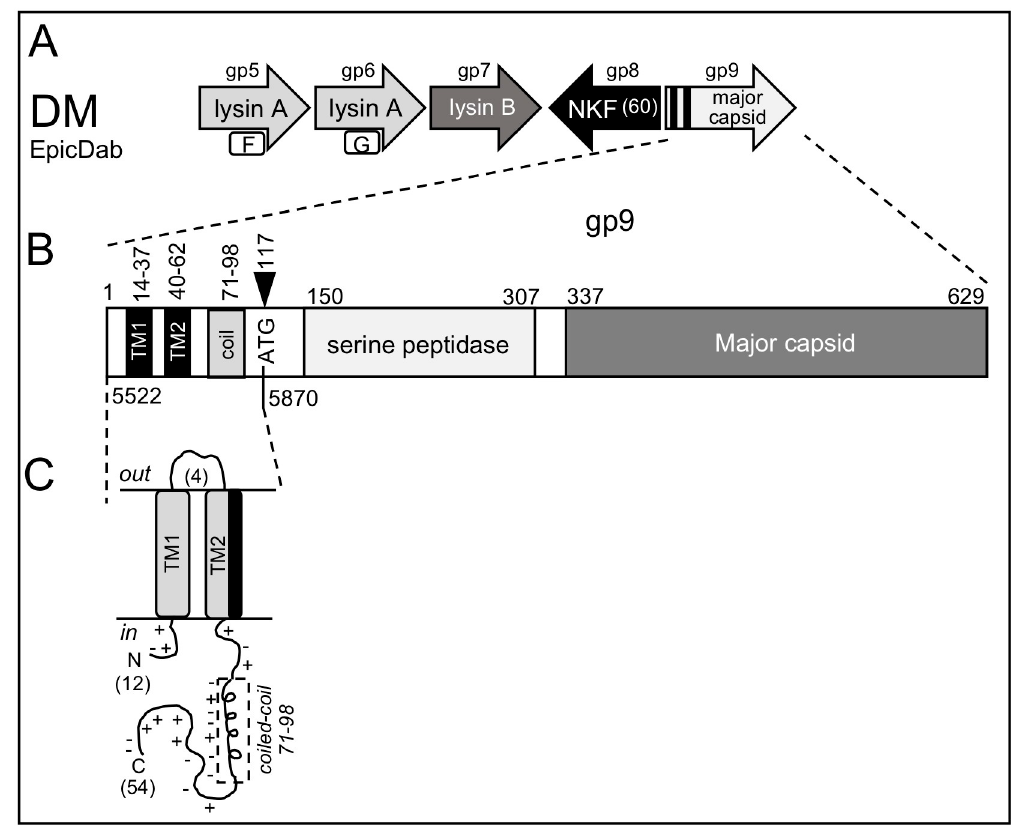
Fig 11. Genomic organization a lysis cassettes with a lysA and lysB in the same location and no holin like genes. A. The genomic structure is shown and the key to the schematic is presented in Fig 1. The direction of transcription of each gene is represented by the arrowhead. B. Structure of the major capsid protease fusion protein. All domains identified are shown with amino acid numbers on the top. The ATG start codon at nucleotide 5870 is shown by the arrowhead. C. Predicted structure of the protein region between amino acids 1–116 if it was liberated from the full-length protein. TM regions are indicated by the gray areas spanning the membrane. TM regions with dark shading to one side indicate a hydrophilic face. Coiled-coil region is shown in dashed box. N = N-terminal; C = C-terminal;+ = location of a positive residue (RKH);— = location of a negative residue (DE); numbers in parenthesis indicate residues.